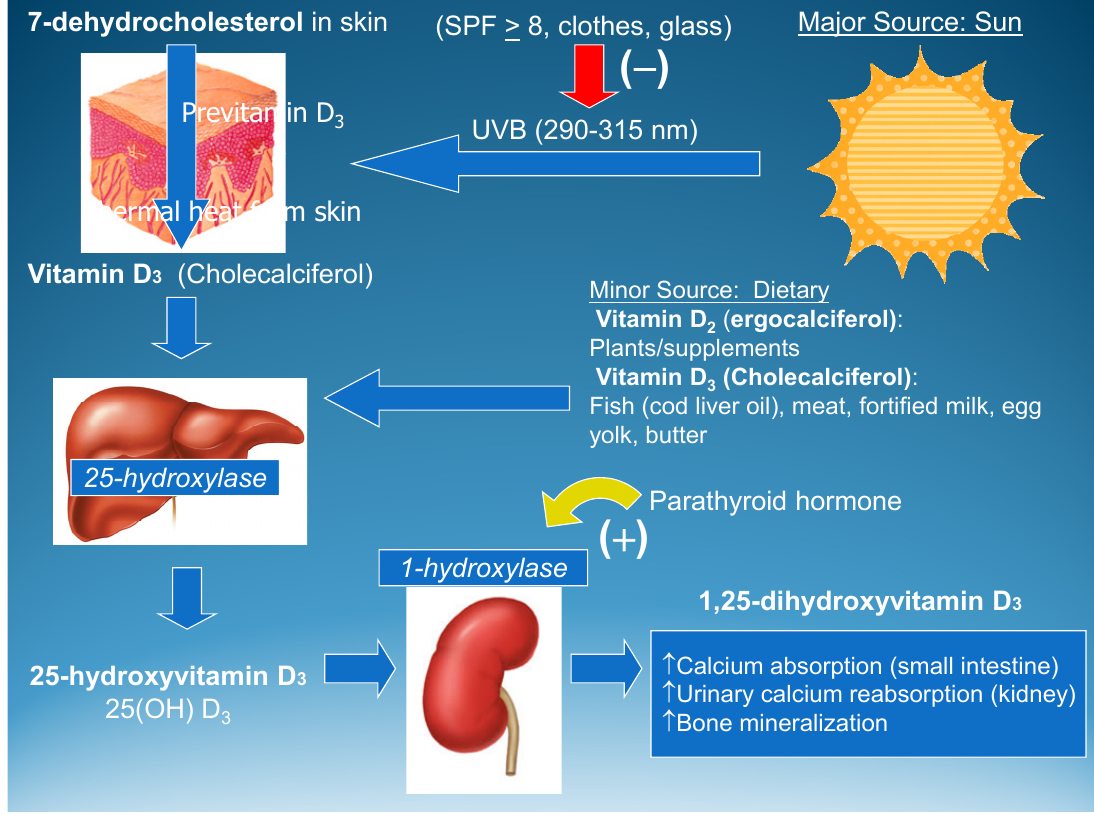
Figure 1. Human vitamin D synthesis pathways. Reproduced with permission from